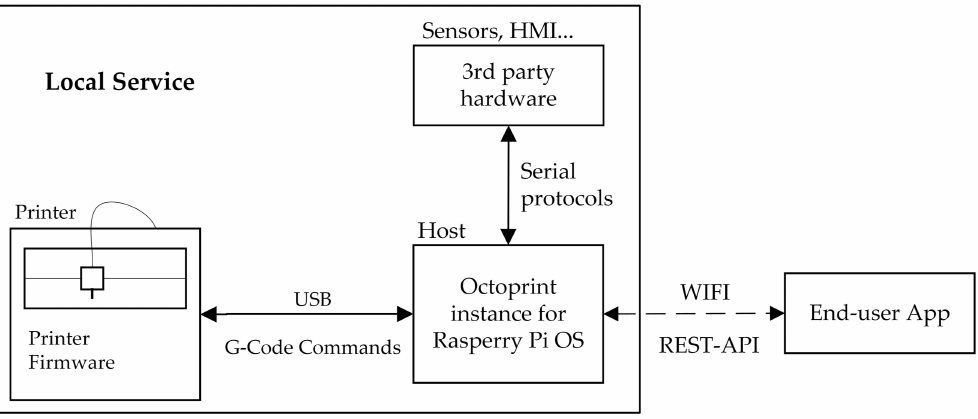
Figure 2. Local service constitution and link to end-user